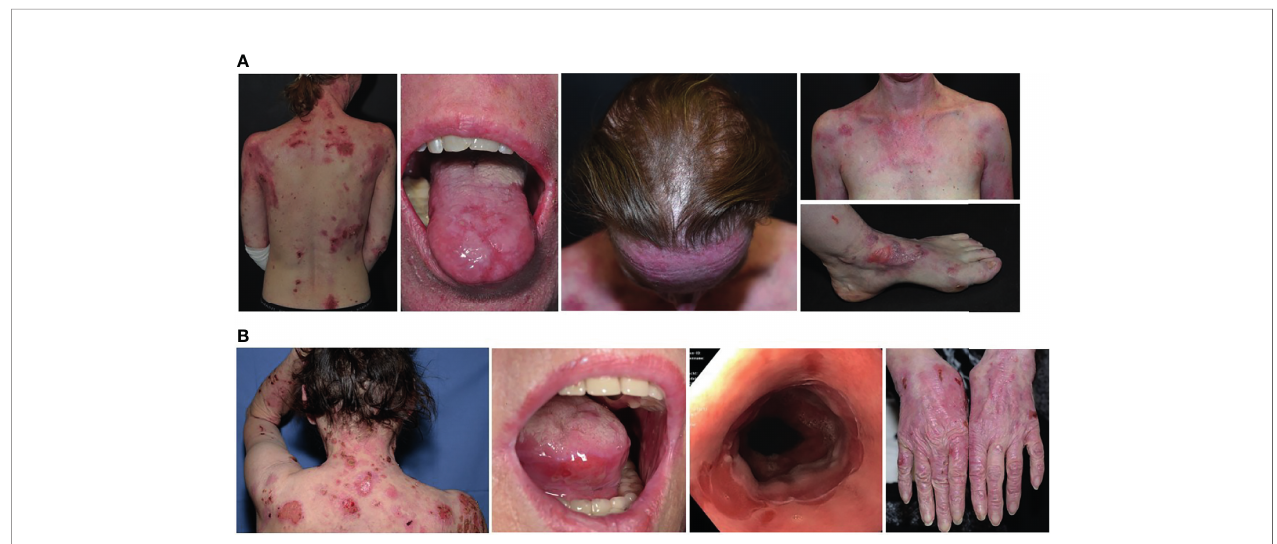
FIGURE 1 | Clinical manifestations in both cases. (A) Clinical presentation of case 1 with blisters, erosions and scaring of her back, tongue, scarring alopecia, chest and nail dystrophy/loss presented at her left foot. (B) Case 2 shows similar lesions on her skin, mucous membranes (mouth and esophagus), as well as progressive scarring and milia on the backs of the hands. The fi nger nails are